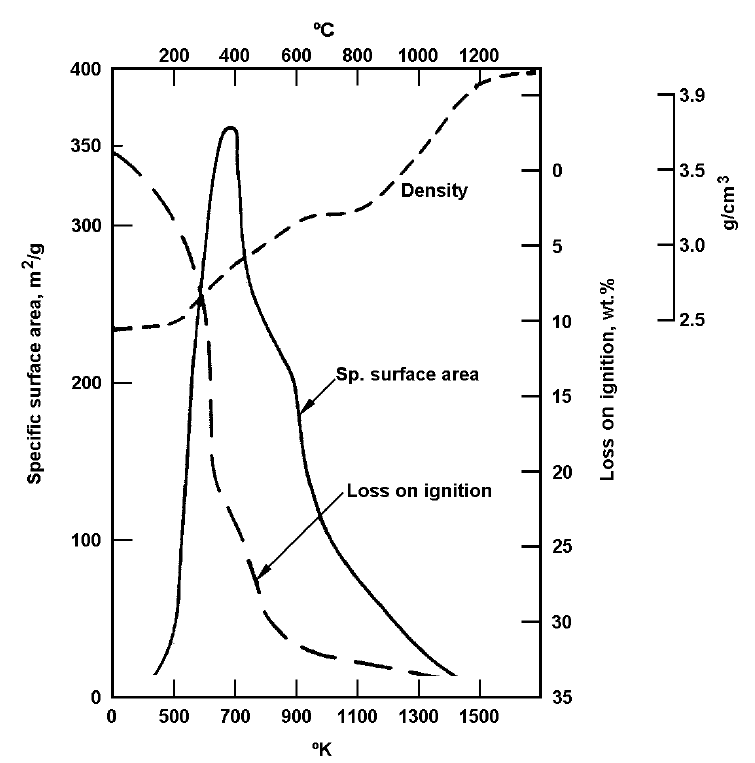
Fig. 12 – Specific surface area ( m 2 /g ) of the transition aluminas from heating Bayer gibbsite crystals (adapted from Figure 22 from Wefers & Bell